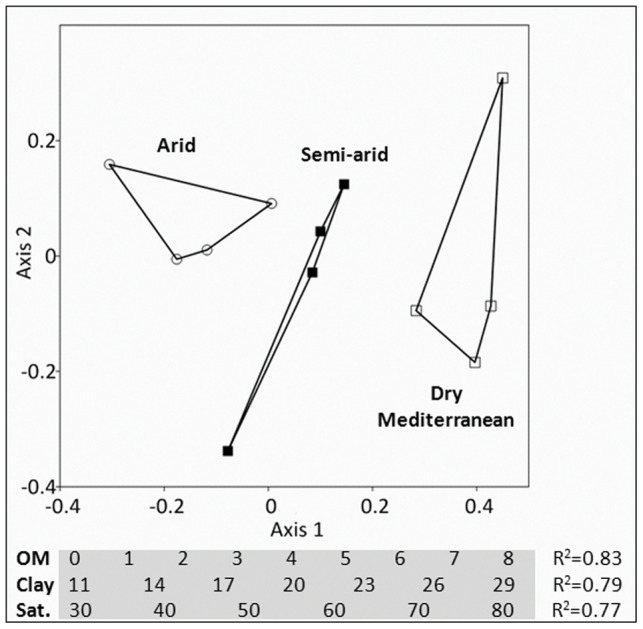
NMDS ordination of bacterial communities from arid, semi-arid and dry Mediterranean soils (stress = 13%).Closer points imply more similar communities. Bacterial communities differ significantly between the three locations (MRPP test, P<0.05). Axes of the ordination have no biological meaning; however, percentages of organic matter (OM), clay and water saturation (sat.) in the soils correlated well with axis 1 (see R2 values in graph) and can each reliably replace it.